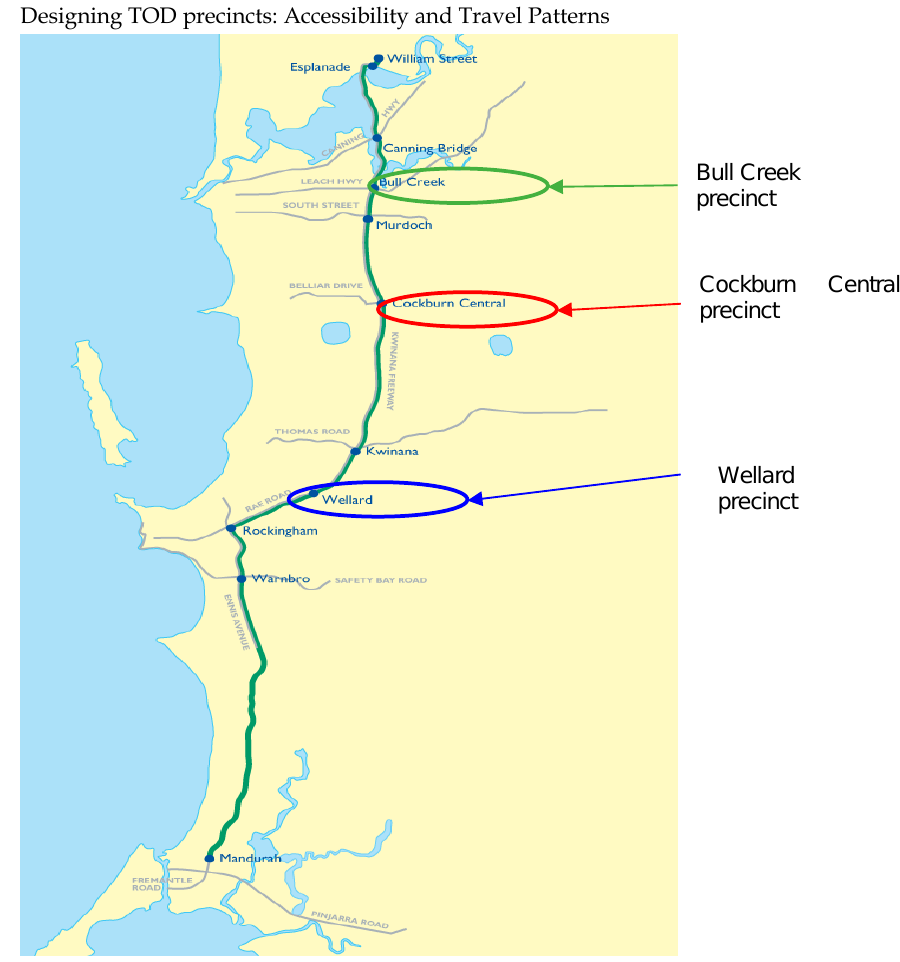
Figure 1. Railway corridor and study